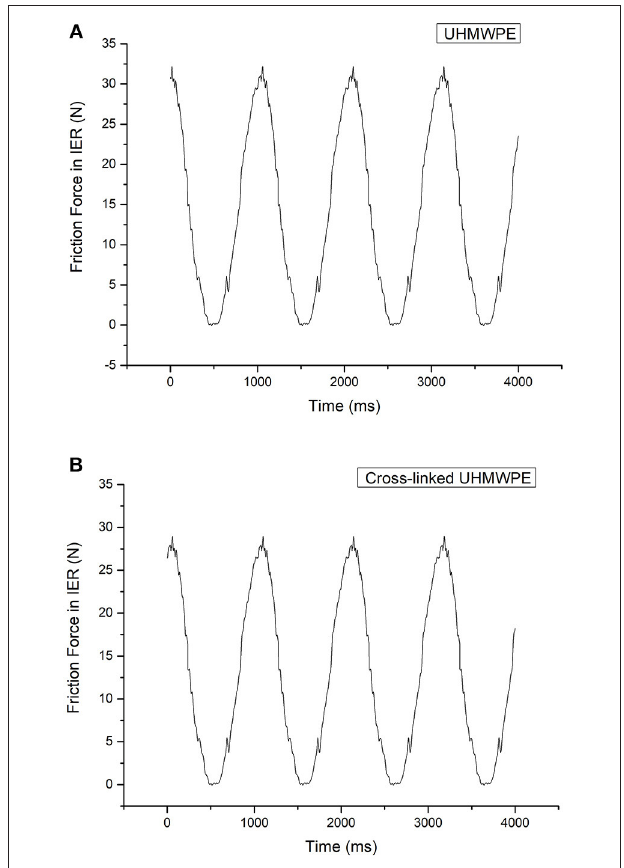
FIGURE 5 | Frictional force obtained from the new developed friction module with serum lubrication: (A) UHMWPE acetabular cup (max: 33N), (B) x-linked UHMWPE acetabular cup (max: